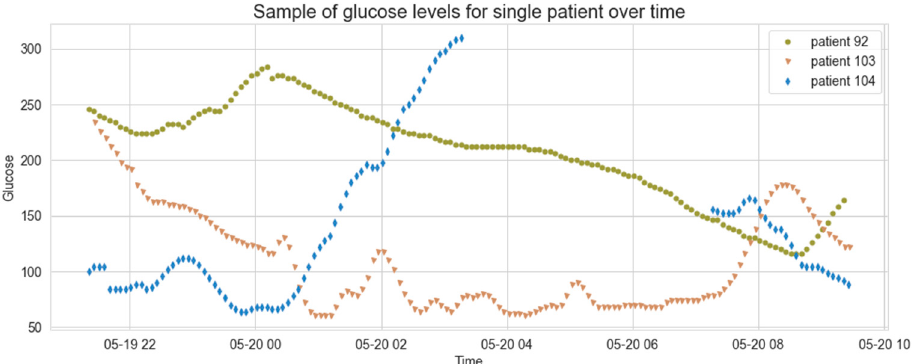
Figure 3. Glucose levels of randomly selected patients over time.